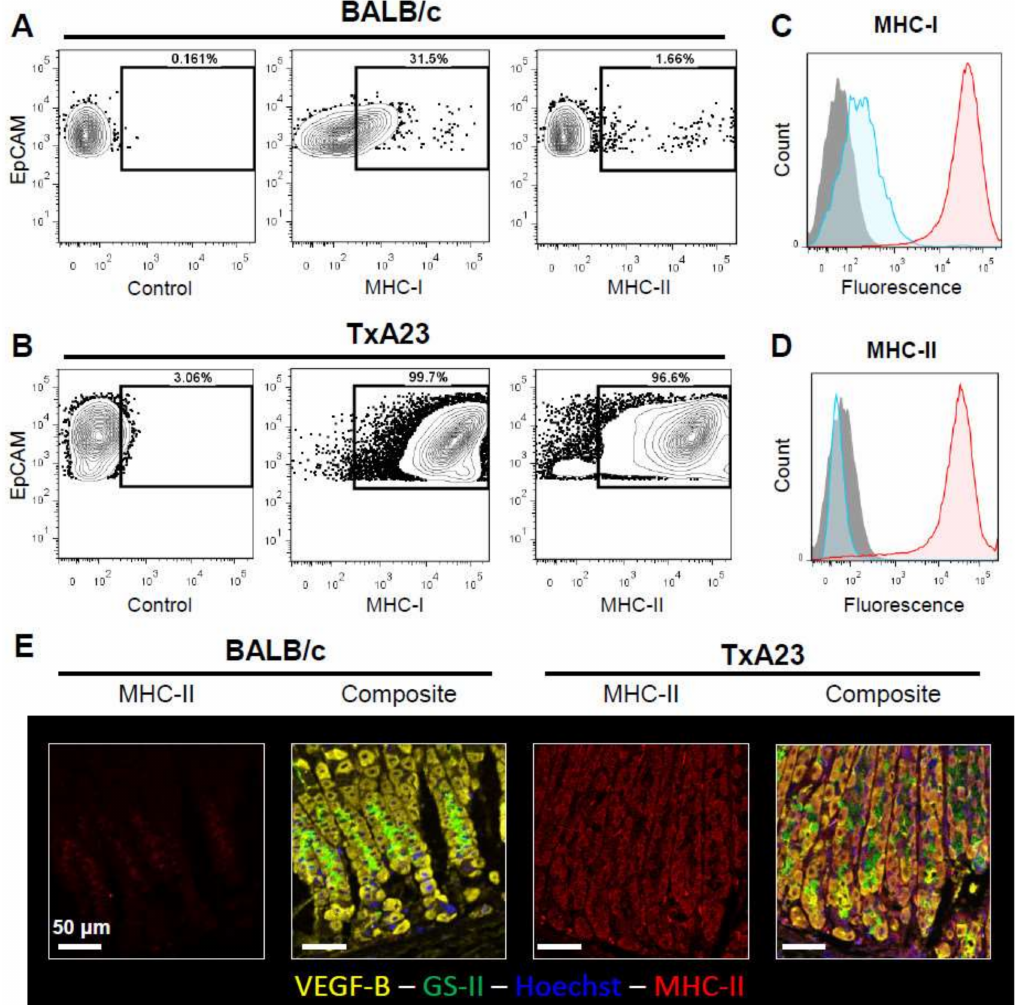
Figure 3. Gastric epithelial cells upregulate MHC-I and MHC-II in response to inflammation. ( A , B ) Representative flow plots of EpCAM+CD45-gated cells stained with antibodies to detect MHC-I or MHC-II surface proteins. Identical gating strategies show that MHC-I and MHC-II molecules are expressed at higher levels on gastric epithelial cells from mice with autoimmune gastritis (TxA23 mice). ( C , D ) Histograms showing the relative expression of MHC I and MHC II in BALB/c (blue) and TxA23 (red) mice. Data are representative of 2 experiments, 5 mice per group. ( E ) Representative images of gastric tissue sections from BALB/c and TxA23 mice stained with Hoechst (blue), VEGF-B (yellow), GS-II (green), and MHC-II